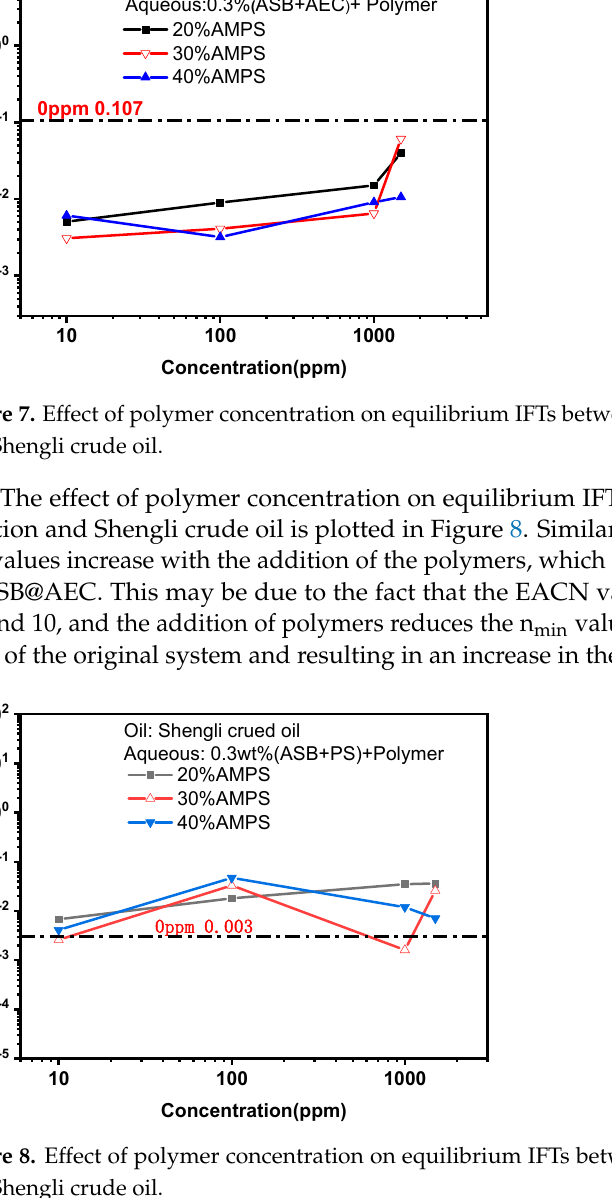
8 of 12 Figure 6. Effect of concentration on equilibrium IFTs of ASB@PS and ASB@AEC solutions against Shengli crude oil. As shown in Figure 7, the addition of different concentration polymers led to a sig- nificant decrease in the IFT between betaine ASB@AEC and crude oil, and an ultra-low IFT can be achieved at wide polymer concentration range. Moreover, the IFT slightly in- creases with the increase in polymer concentration. This may be due to the fact that the low polymer concentration may promote the interfacial film alignment and lead to the decrease in IFT, while the high concentration makes the interfacial alignment looser, and the IFT slightly increases [27,29]. The IFT between ASB@AEC and crude oil was only 10 -2